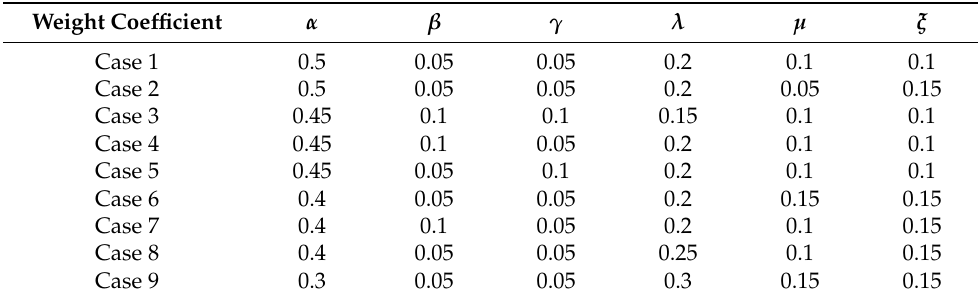
Table 3. Combination of weight